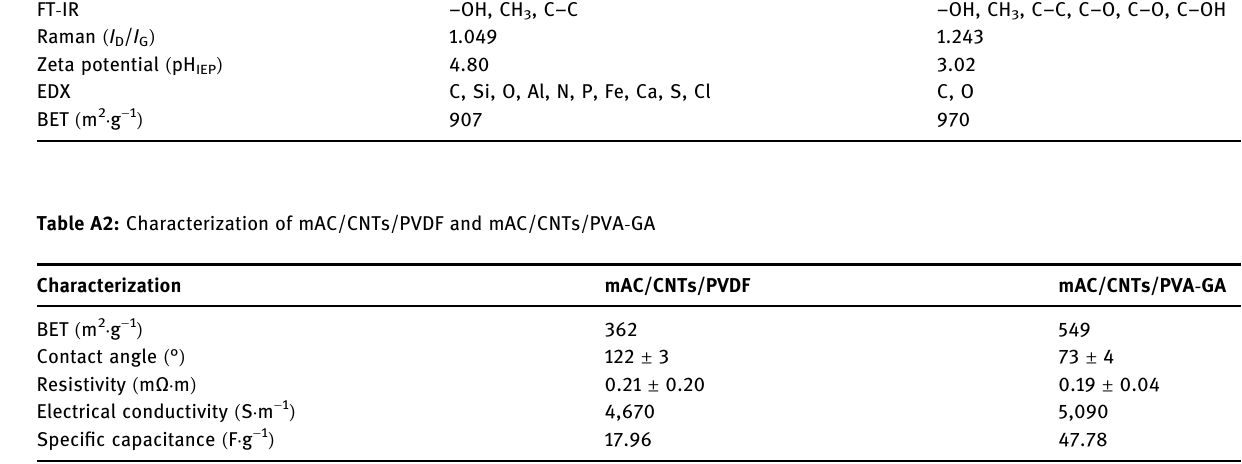
Table A1: Characterization of AC and mAC Characterization